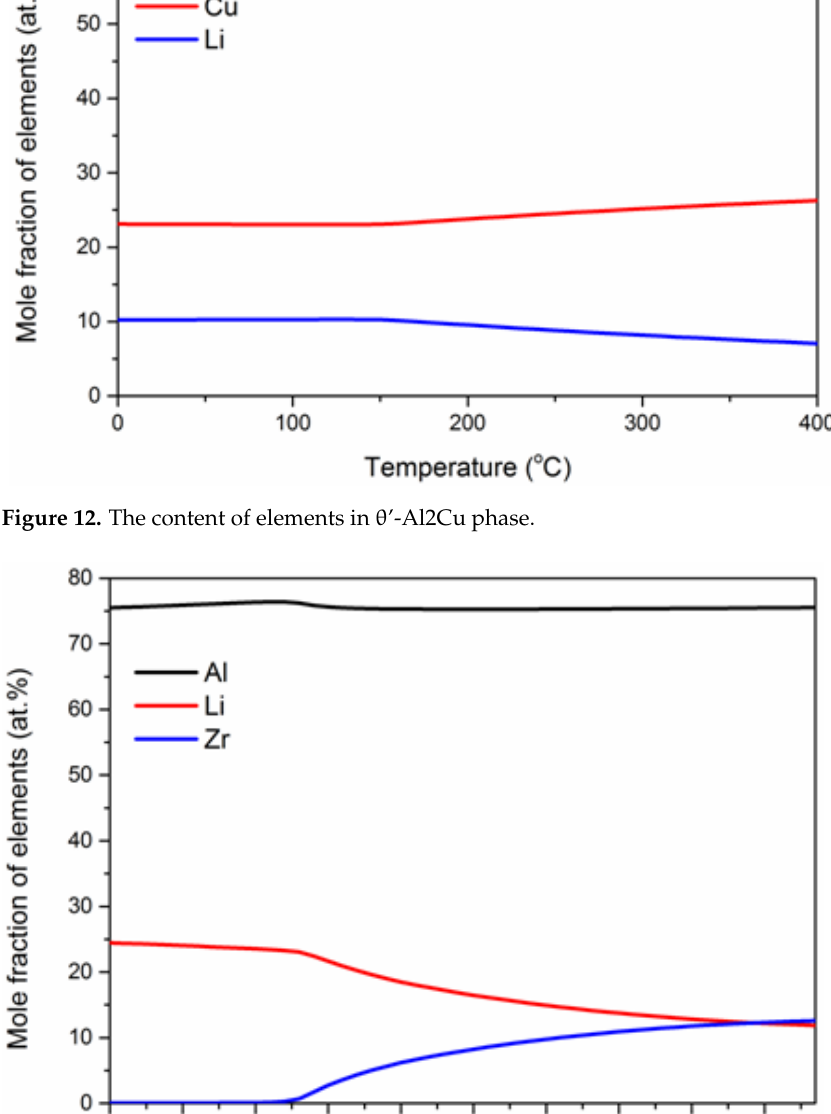
Figure 13. The content of elements in δ ’-Al3Li phase.